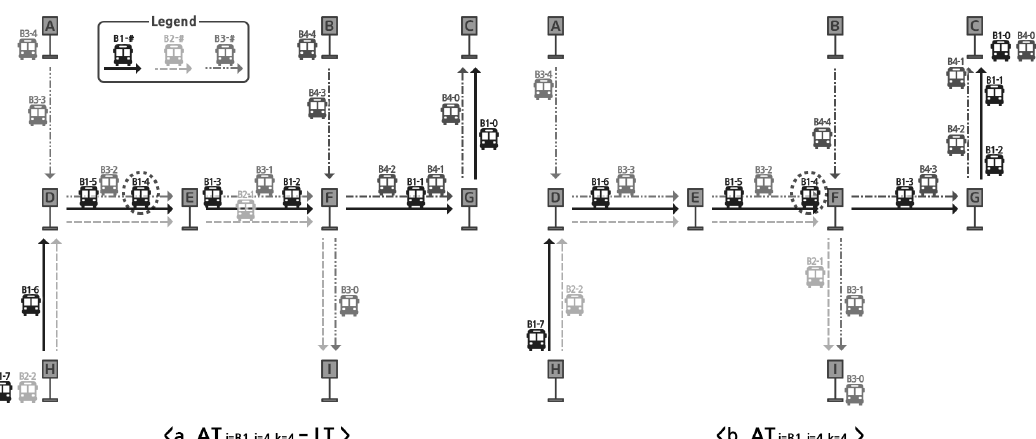
Figure 3. Snapshot of a sample bus network and snapshot focusing on the bus stop F. Symbols A through I represent bus stops.